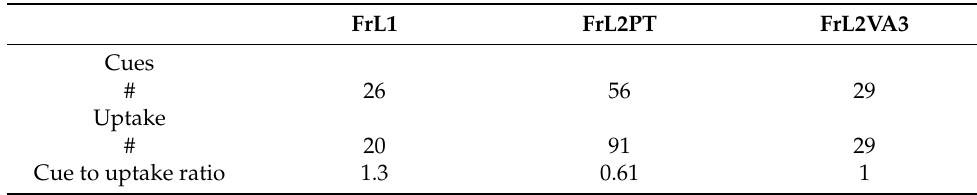
Table 3. Occurrences of je pense following an interactional cue.